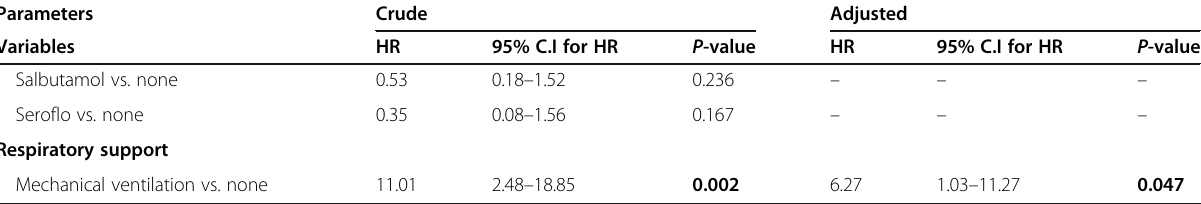
Table 2 Data analysis using the crude and adjusted Cox regression models (Continued) Parameters